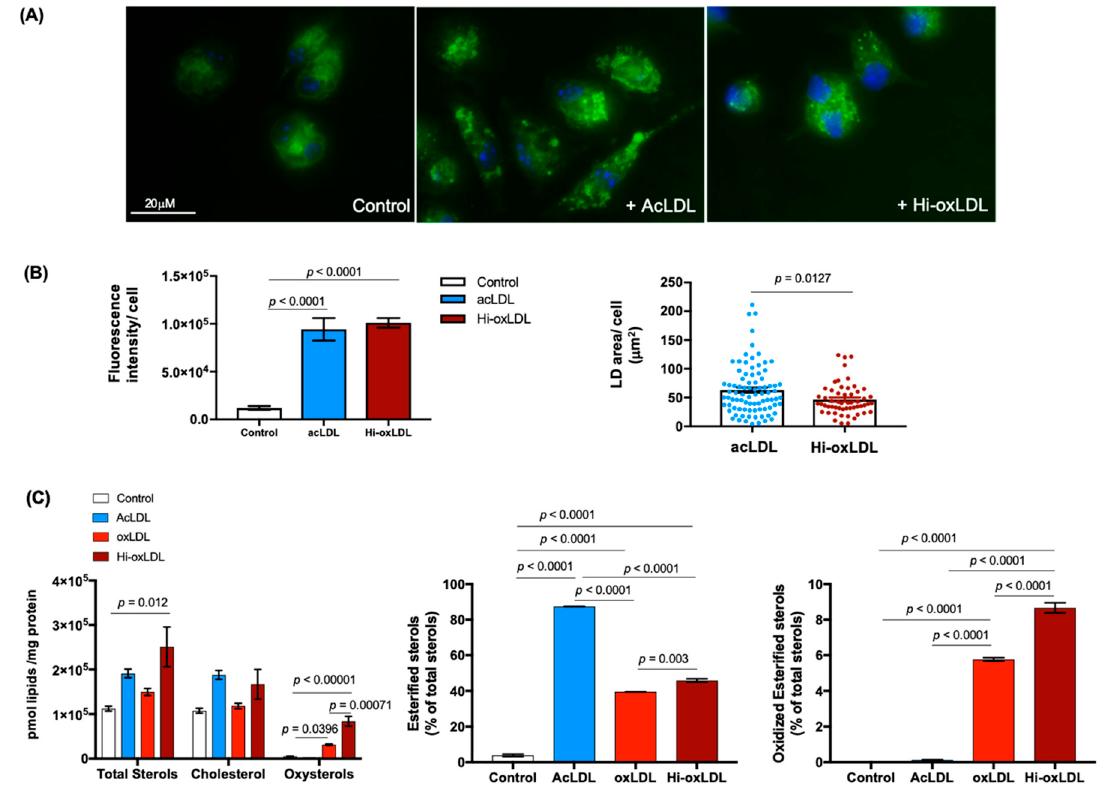
Figure 1. Oxidized low-density lipoprotein (LDL) enriches oxysterols in macrophage foam cells. ( A ) Foam cell formation. Mouse peritoneal macrophages (MPMs) plated on a coverslip remained untreated (left) or were loaded with either acLDL (middle) or hi-oxLDL (right) for 24 h to generate low-density lipoprotein (LDs). LDs were visualized with Bodipy 483 / 503 staining (green) and nuclei were stained with DAPI (blue). ( B ) Total Bodipy fluorescence intensity per cell represents total lipid contents (left). Area of LD per cell was measured and presented in µ m 2 / cell. n = 88 for acLDL and n = 55 for Hi-oxLDL-treated MPMs. ( C ) Sterol contents of foam cells treated with modified LDLs. MPMs